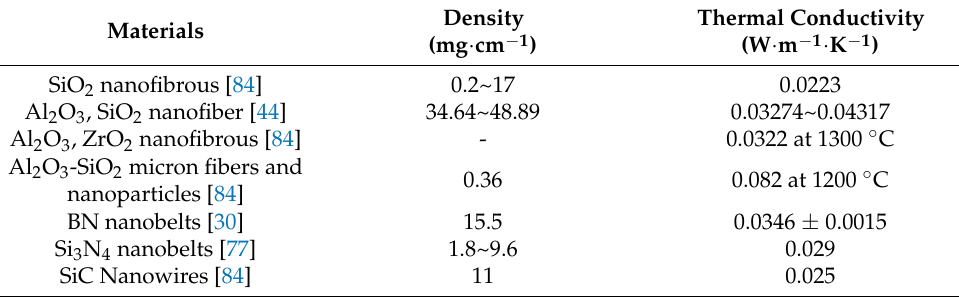
Table 2. Physical properties of some high-temperature nanofibers aerogel.